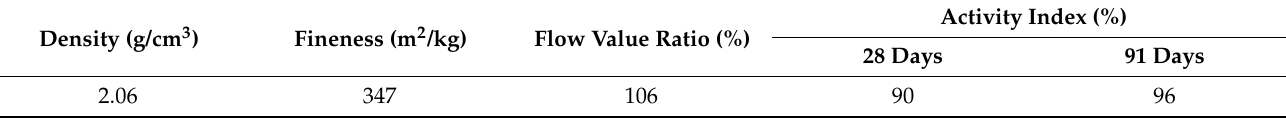
Table 5. Chemical composition of cement.